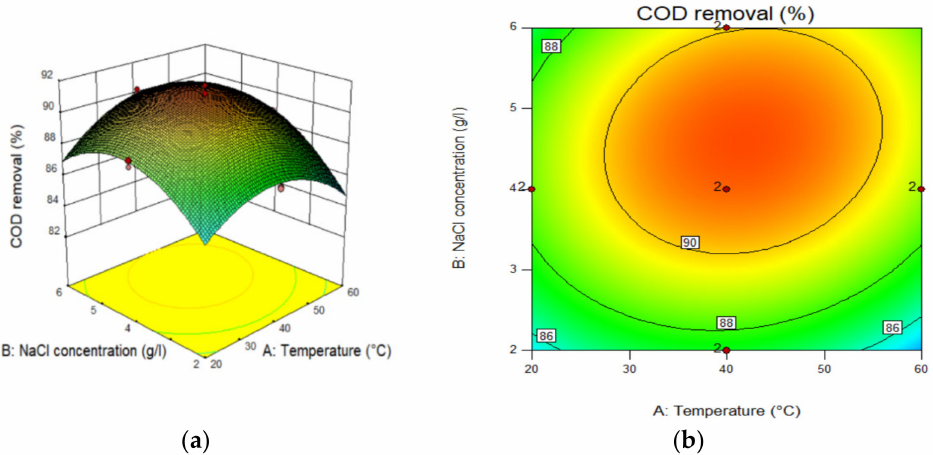
Figure 5. ( a ) Three-dimensional (3D) response graph and ( b ) contour plot for the effect temperature and NaCl